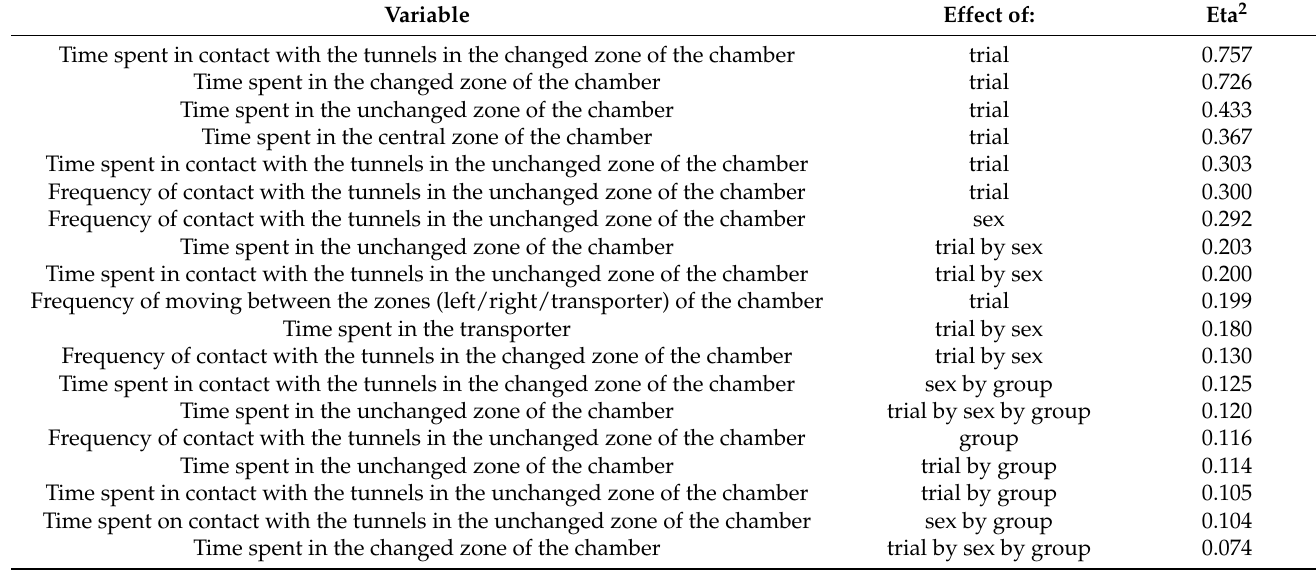
Table 3. The ranking list of statistically significant effects based on the partial Eta 2 values.